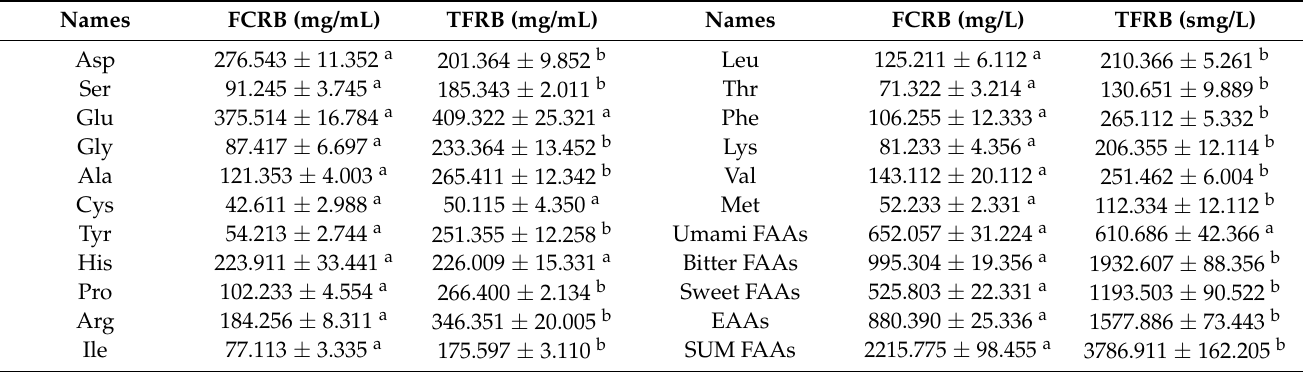
Table 1. The amino acids species and contents in the FCRB and